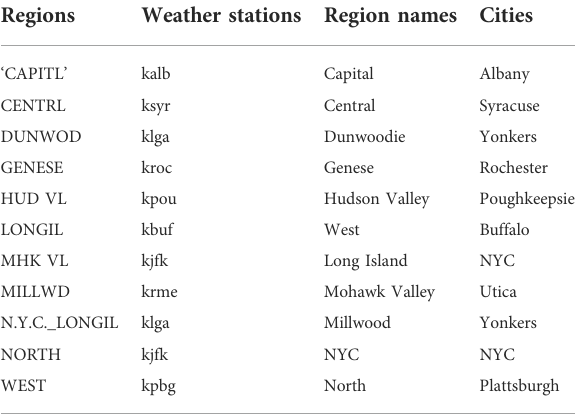
TABLE 1 Mapping of regions, cities, and weather stations. Regions